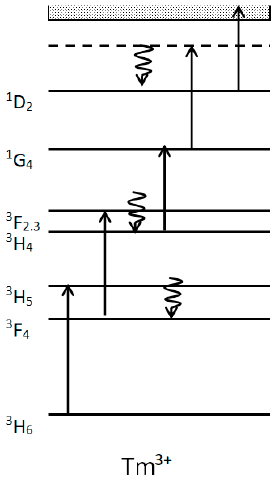
Figure 1. Partial energy level diagram of Tm 3+ . Straight arrows correspond to absorption at 1064 nm, whereas wiggly arrows indicate nonradiative decay.